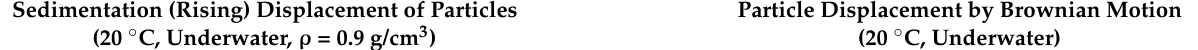
Table 5. Comparison of the displacement (velocity) of particles of different sizes in water and displacement (velocity) of particles because of Brownian